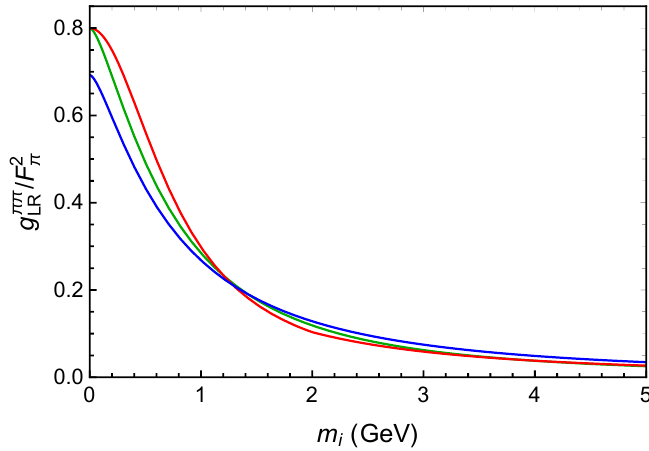
Figure 4 . The LEC g (cid:25)(cid:25) in units of F 2 as a function of the neutrino mass m i . The blue and green (cid:25) LR lines denote the three- and (cid:12)ve-resonance models, while the red line denotes the naive interpolation formula in eq.